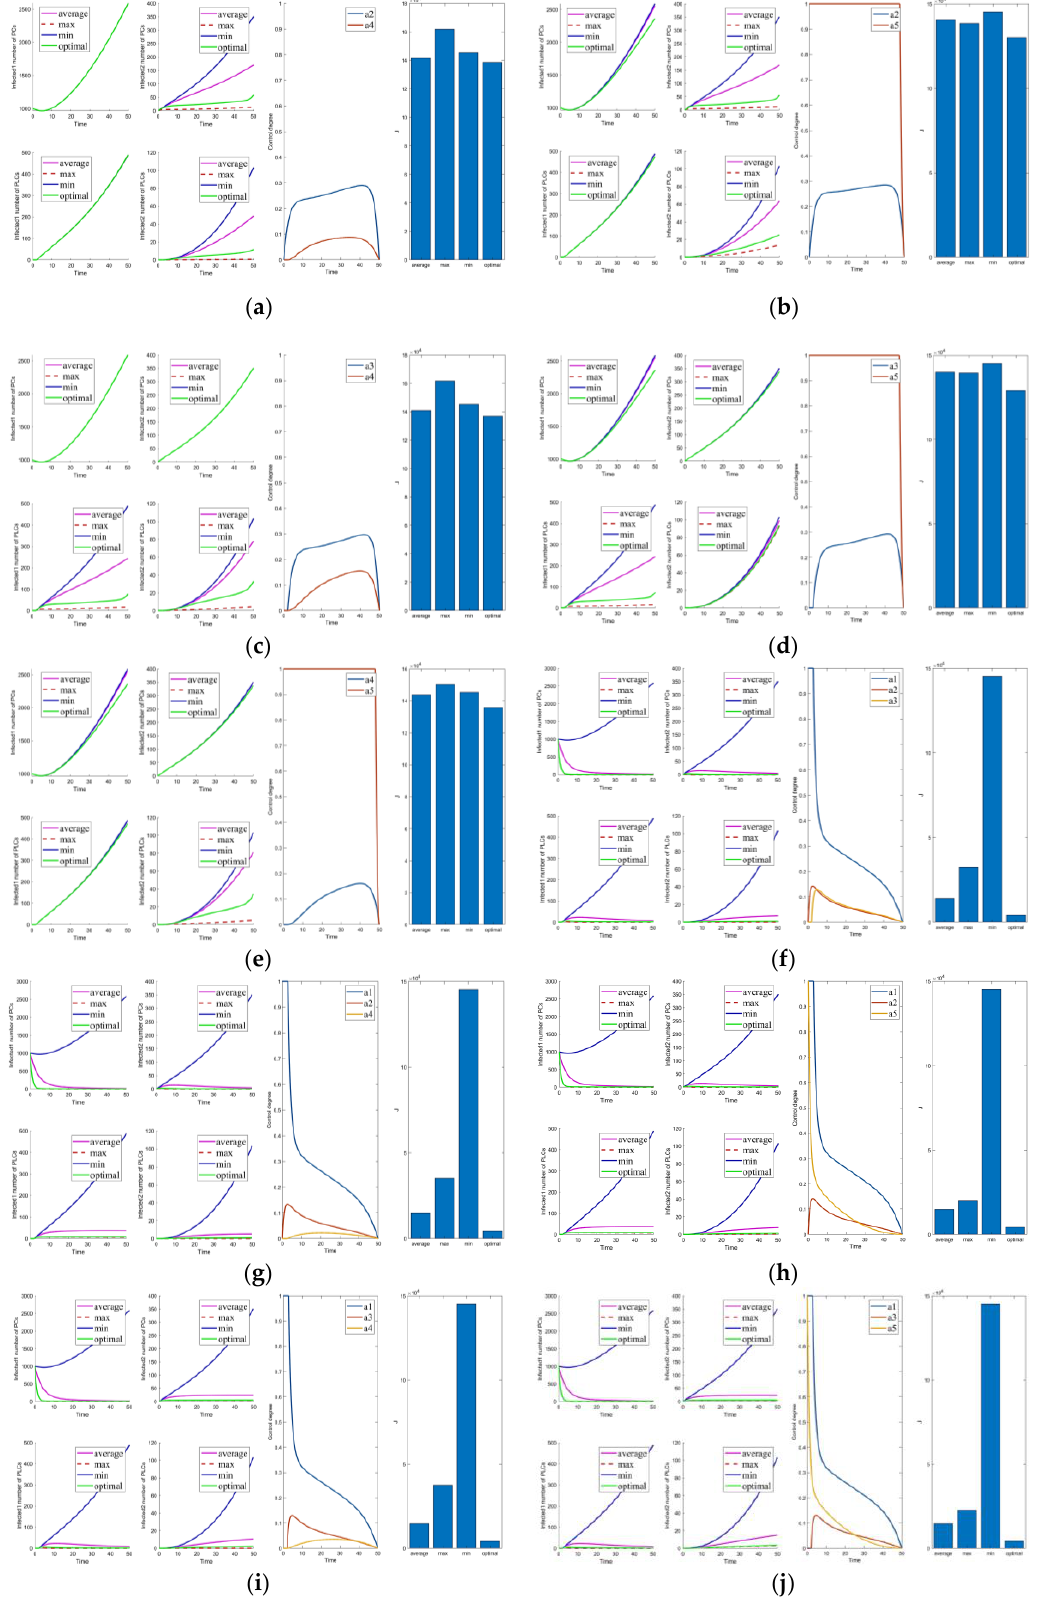
Figure 9. Solutions of the optimal control strategies for Cases 11 – 20 (removing average constant). ( a ) Case 11; ( b ) Case 12; ( c ) Case 13; ( d ) Case 14; ( e ) Case 15; ( f ) Case 16; ( g ) Case 17; ( h ) Case 18; ( i ) Case 19; ( j ) Case 20.